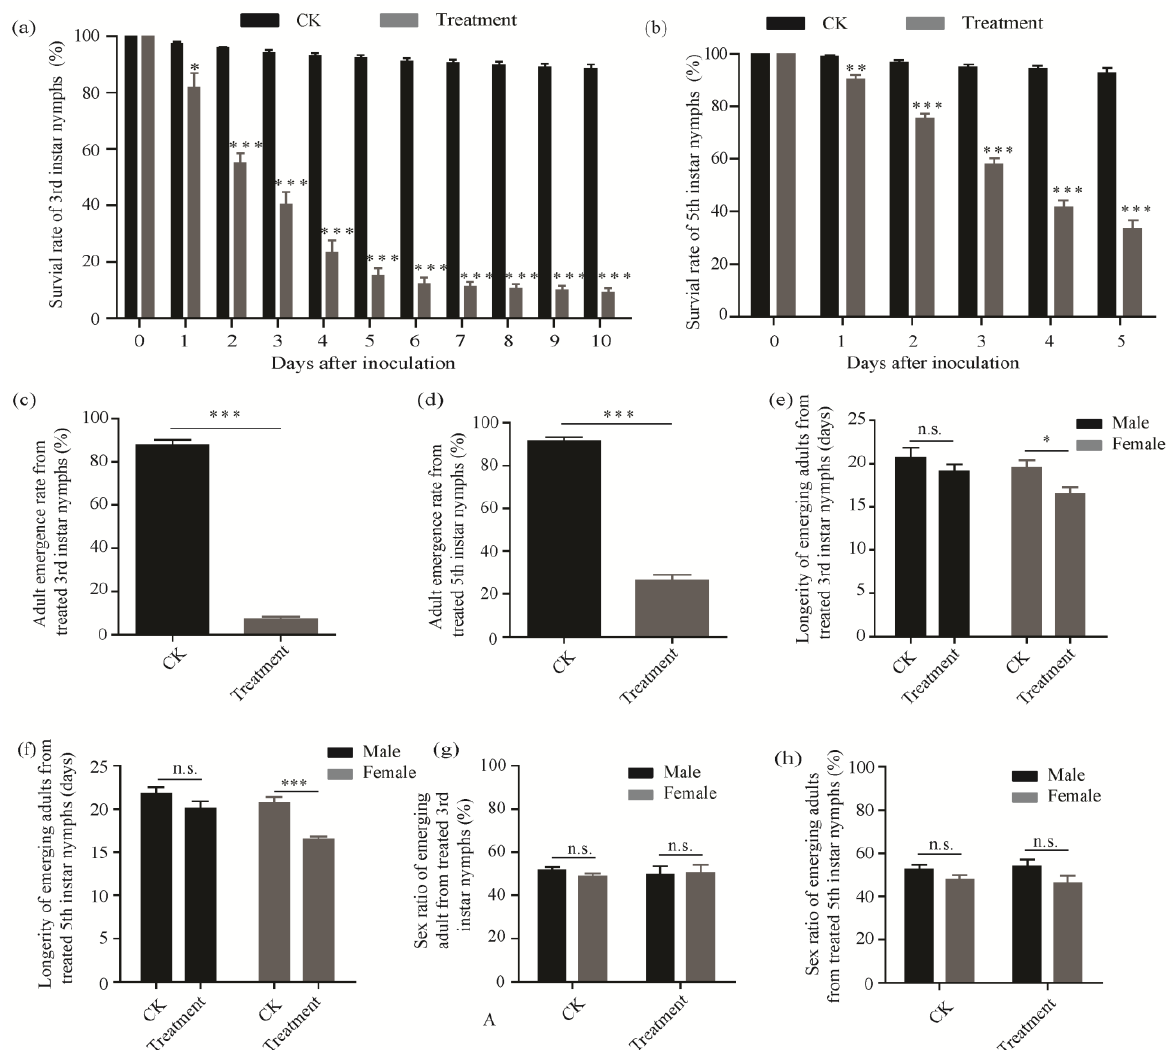
Figure 4. The effects of C. fumosorosea SCAU-CFDC01 on D. citri adults from nymphs treated. Adult survival rate ( a ), emergence rate ( c ), longevity ( e ), and sex ratio ( g ) based on a 3rd instar nymph cohort inoculated with the fungus. Adult survival rate ( b ), emergence rate ( d ), longevity ( f ), and sex ratio ( h ) based on a 5th instar nymph cohort inoculated with the fungus. All the results are presented as the mean ± standard error (SE). T-test statistically significant differences between treatment and CK were denoted by * ( p < 0.05), ** ( p < 0.01), and *** ( p < 0.001). n.s. — not significant.